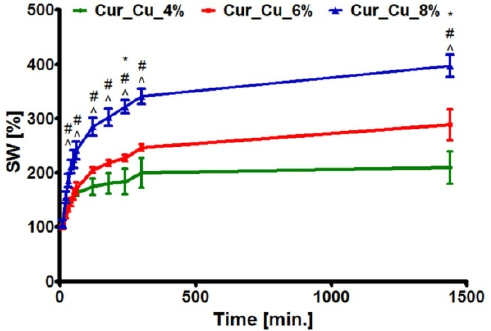
Figure 2. The ability of Cur_Cu_4%, Cur_Cu_6%, and Cur_Cu_8% samples to swell in simulated wound fluid during 24-h incubation. #—significantly different results between Cur_Cu_6% and Cur_Cu_8%, ^—significantly different results between Cur_Cu_4% and Cur_Cu_8%, *—significantly different results between Cur_Cu_4% and Cur_Cu_6%; one-way ANOVA followed by Tukey’s multiple comparison test, p < 0.05.